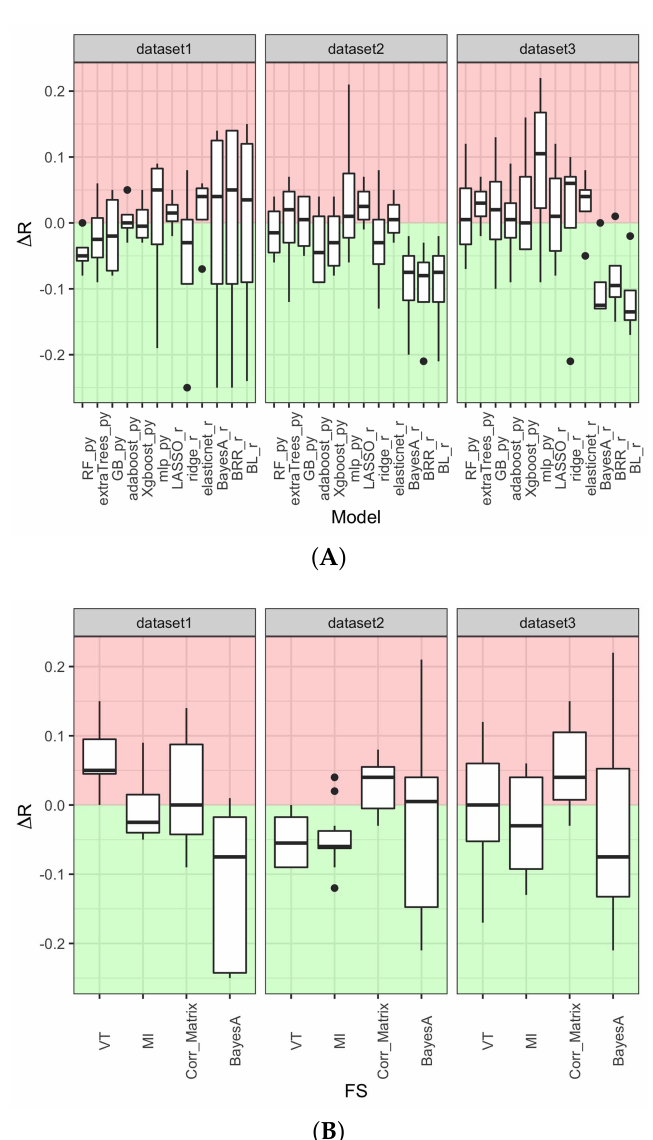
Figure 4. ( A ) Boxplot of the test and train correlation ( R ) score differences (i.e., ∆ R on the y -axis) of the 12 prediction models of dataset1, dataset2, and dataset3. Each model name is denoted by the method name and programming platform where they are implemented. ( B ) Boxplot of the test and train cor- relation ( R ) score differences (i.e., ∆ R on the y -axis) of the 12 prediction models of dataset1, dataset2, and dataset3 of 4 feature selection methods. VT = variance threshold, Corr_Matrix = correlation matrix, MI = mutual